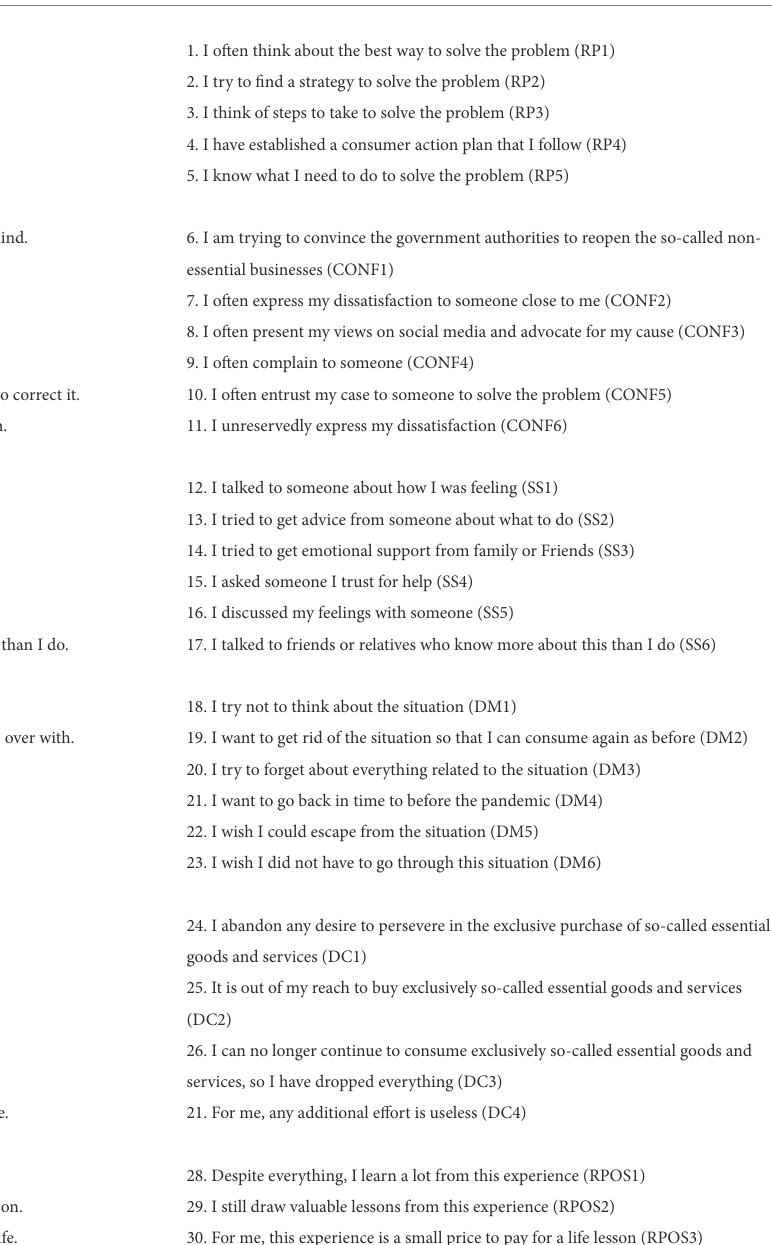
TABLE 1 Items adapted to the study. Items of Yi and Baumgartner (2004) Adaptation to the current